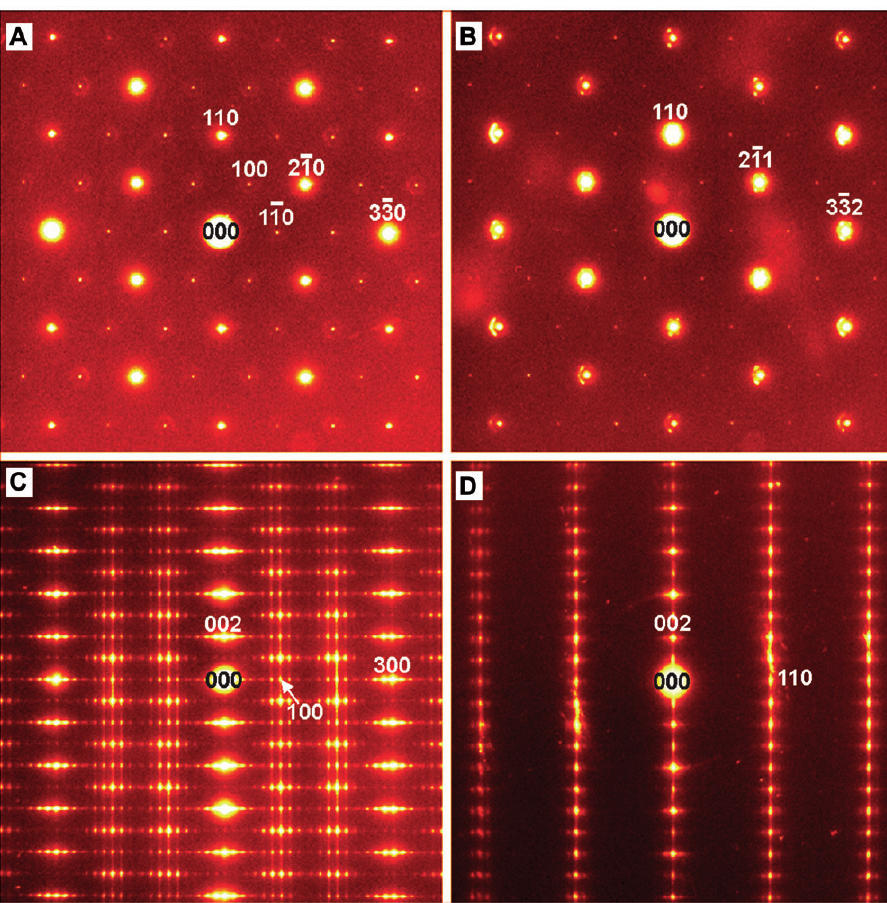
Figure 3 Electron diffraction patterns recorded along (A) [001], (B) [1 - 13], (C) [010], and (D) [11 - 0] directions of Ag to cell determined by